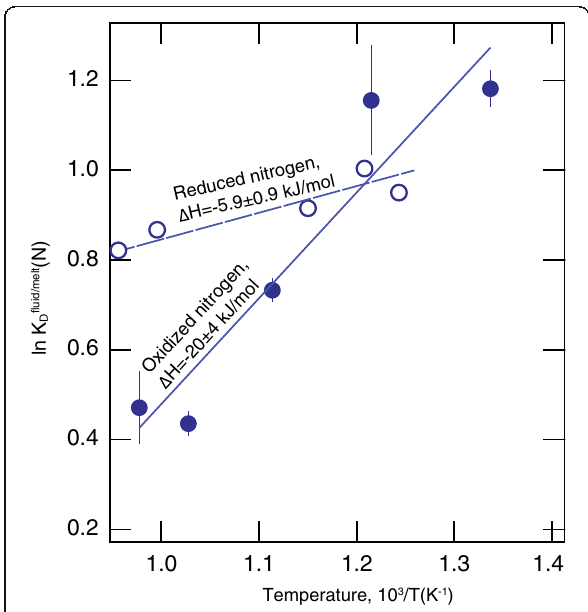
Fig. 14 Fluid/melt partition coefficients at oxidizing and reducing conditions as a function of temperature (data from Mysen et al.